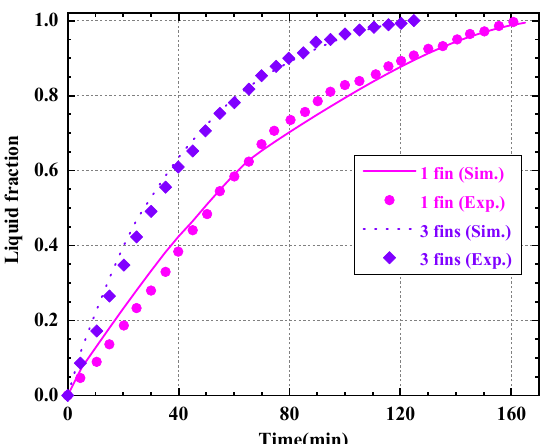
Figure 3. Comparisons among the experiment carried out by Kamkari et al. [45], the present model, Ji et al. model [22] and Abdi et al. model [33] for no fin case.